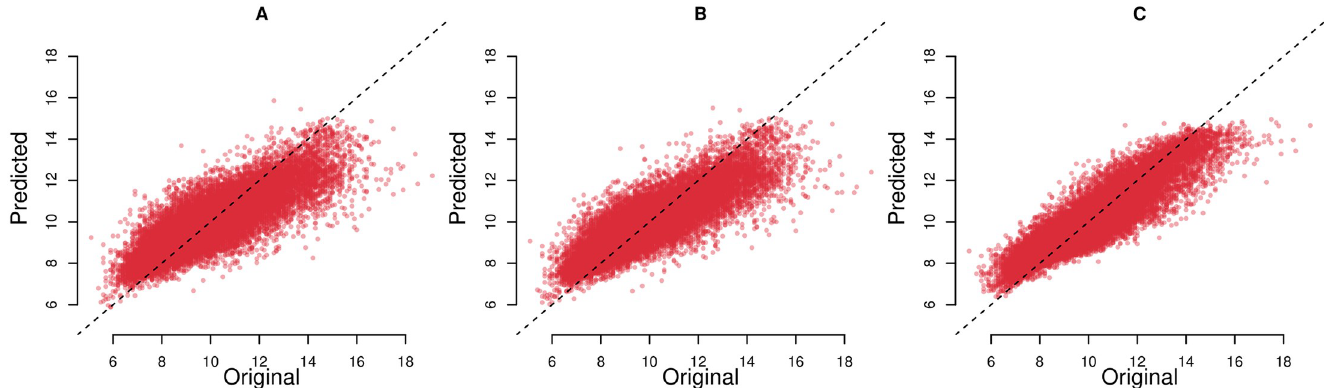
Fig 3. Predicted against original prevalence of asthma. A: Model based on search queries. B: Model based on search queries and land cover data. C: Model based on search queries, census and land cover data. Each point denotes a distinct census tract in the dataset. Dotted line represent x = y.